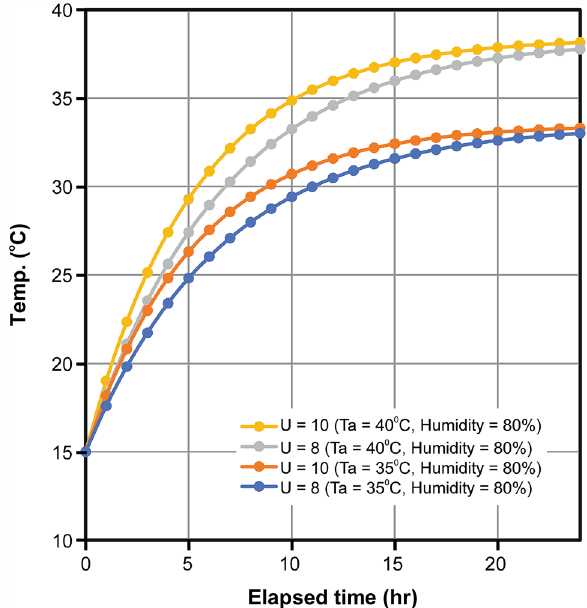
Fig. 5 Water temperature increase simulation. Unit of U is kcal/ m 2 h